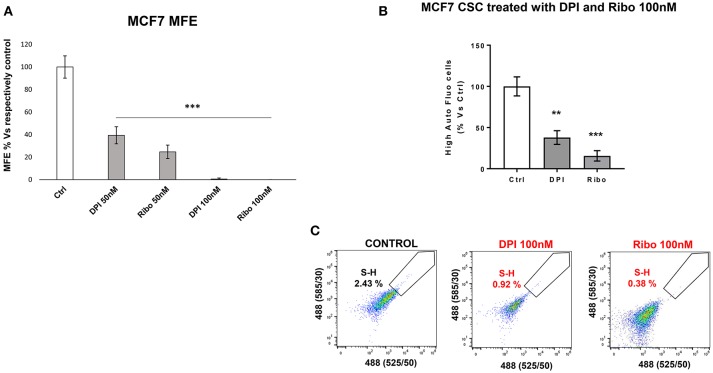
e-CSCs (3D) are susceptible to targeting with DPI or Ribociclib. (A) The bar graph shows that mammosphere formation in MCF7 cells is inhibited in response to DPI or Ribociclib treatment, in a concentration dependent-manner (0, 50, and 100 nM). (B) Note that the percentage of S-H cells are reduced after treatment with either DPI or Ribociclib. (C) Representative flow-cytometry experiments are also shown, as supporting evidence. Therefore, DPI has opposite effects on M-H and S-H cells. As such, DPI selectively targets the S-H sub-population of e-CSCs. **p < 0.001 and ***p < 0.0001.